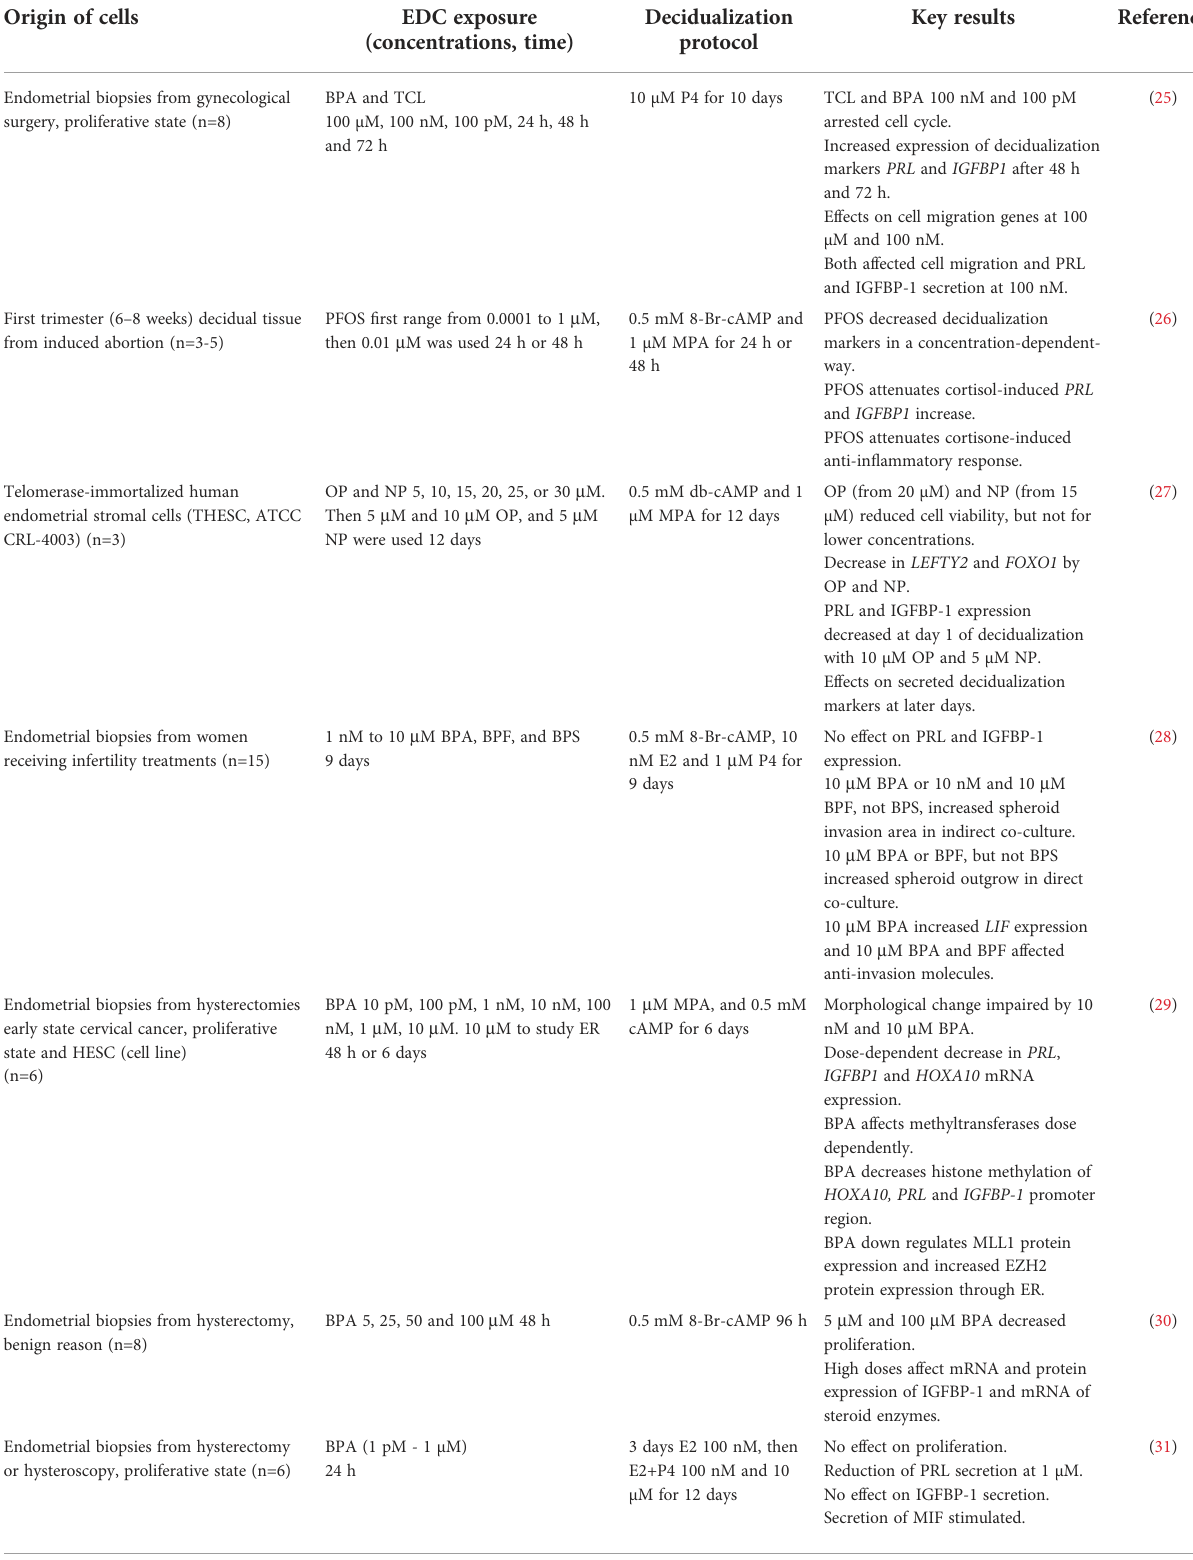
TABLE 1 Summary of literature on the effects of EDCs on human endometrial stromal cell decidualization in vitro. Origin of